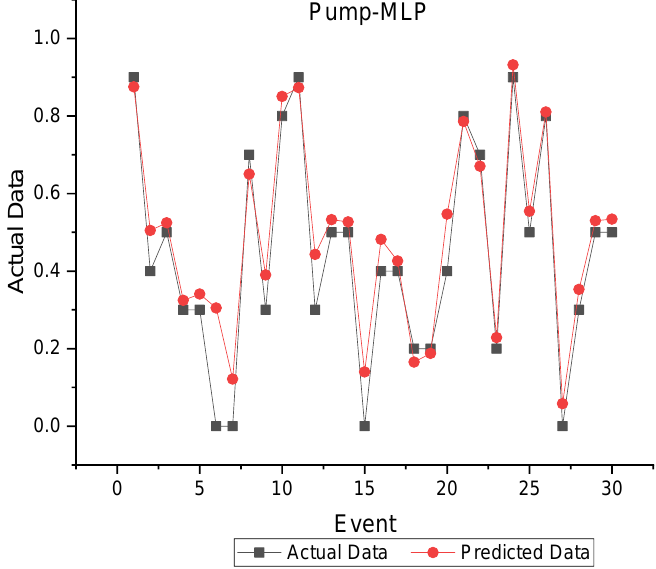
Figure 16. Representation of actual and prediction data for pump MLP.